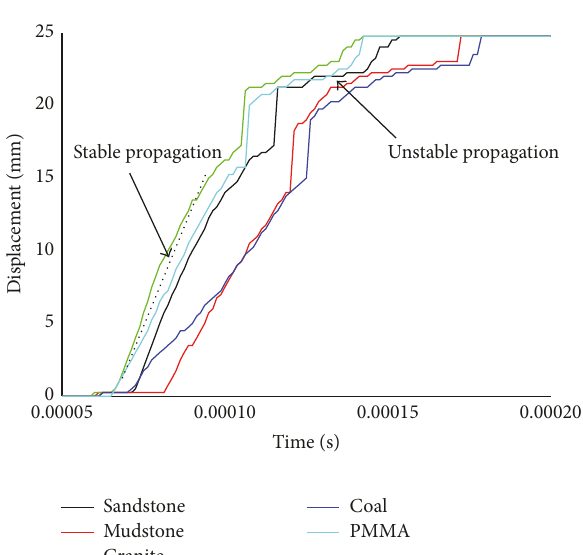
Figure 12: Displacement-time curve for the crack propagation, V 𝑑 = 4 m/s.